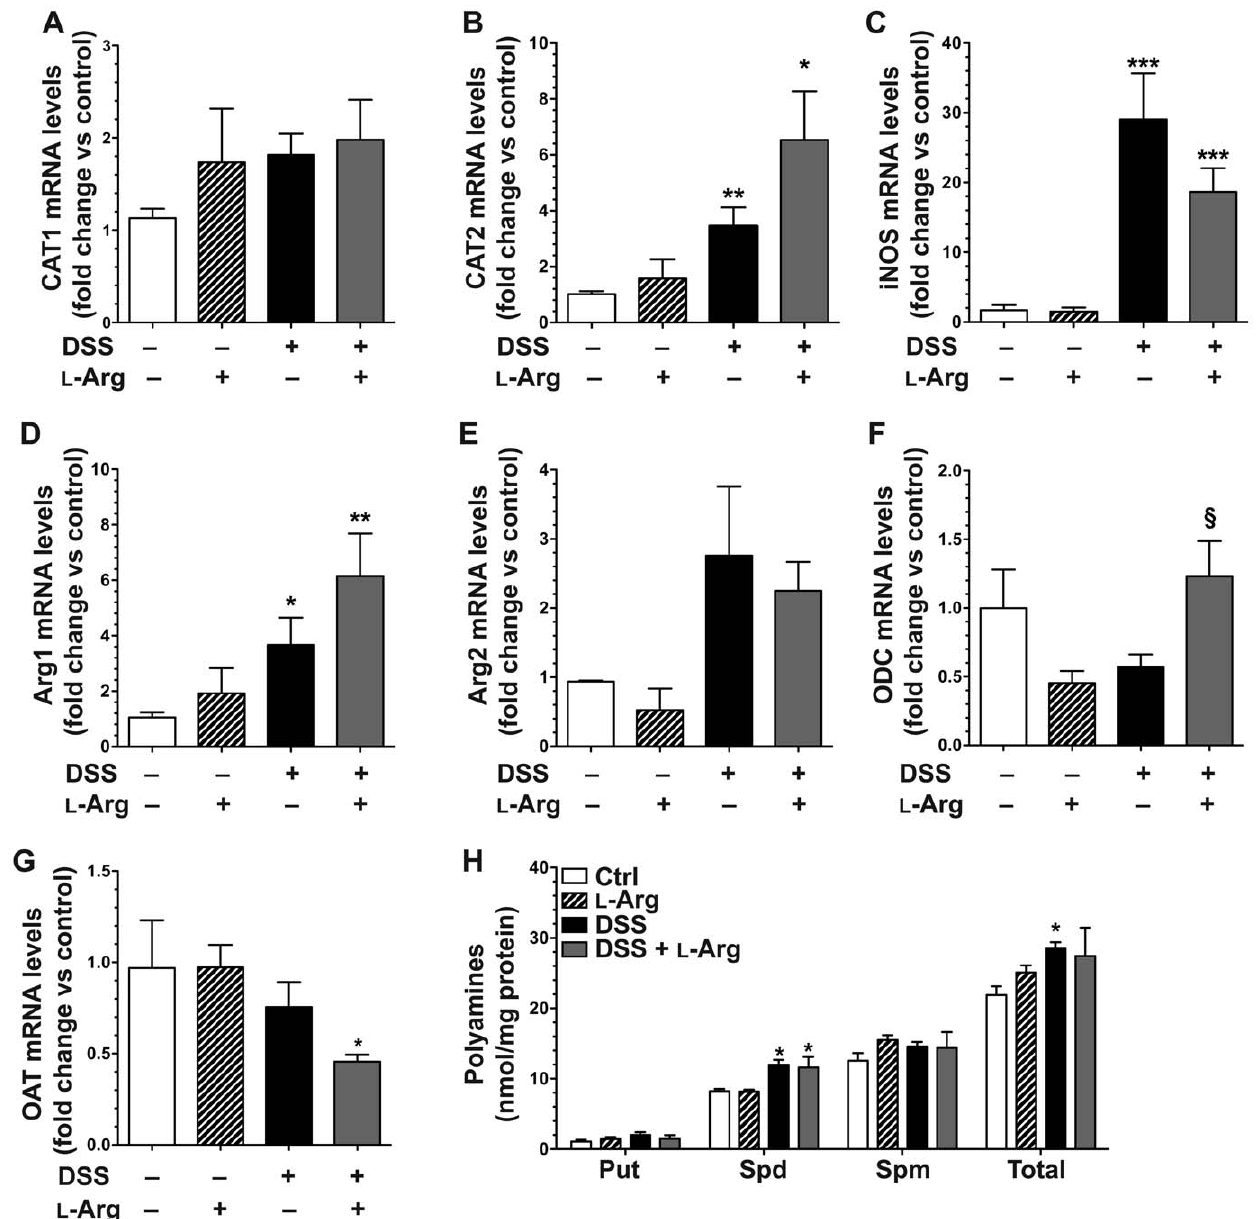
Figure 5. Effect of DSS treatment and L-Arg supplementation on L-Arg metabolic pathways. Mice received 4% DSS 6 1% L-Arg in the drinking water as in Figures 3–4. (A) At sacrifice on day 10, a piece of colon was obtained for RNA isolation or polyamine determination by HPLC. (A– G) Tissue mRNA levels of the genes indicated, as assessed by real-time PCR. (H) Tissue polyamine levels were assessed by HPLC as described in the Methods. n =4–15 per group. * p , 0.05, ** p , 0.01, *** p , 0.001 vs. control. 1 p , 0.05 vs.